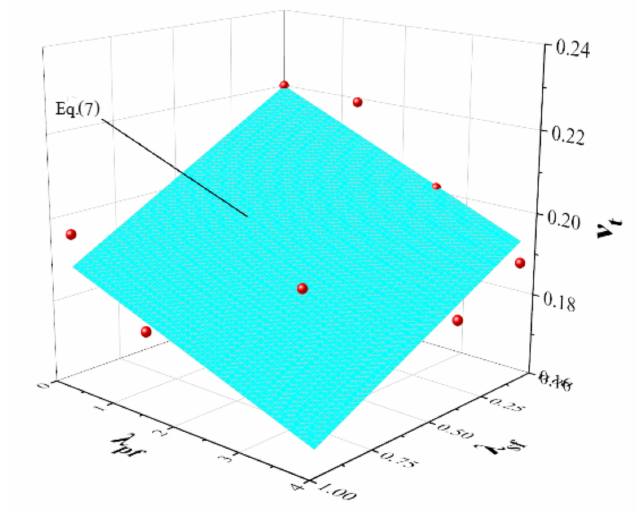
Figure 16. Fibre characteristic value and Poisson’s